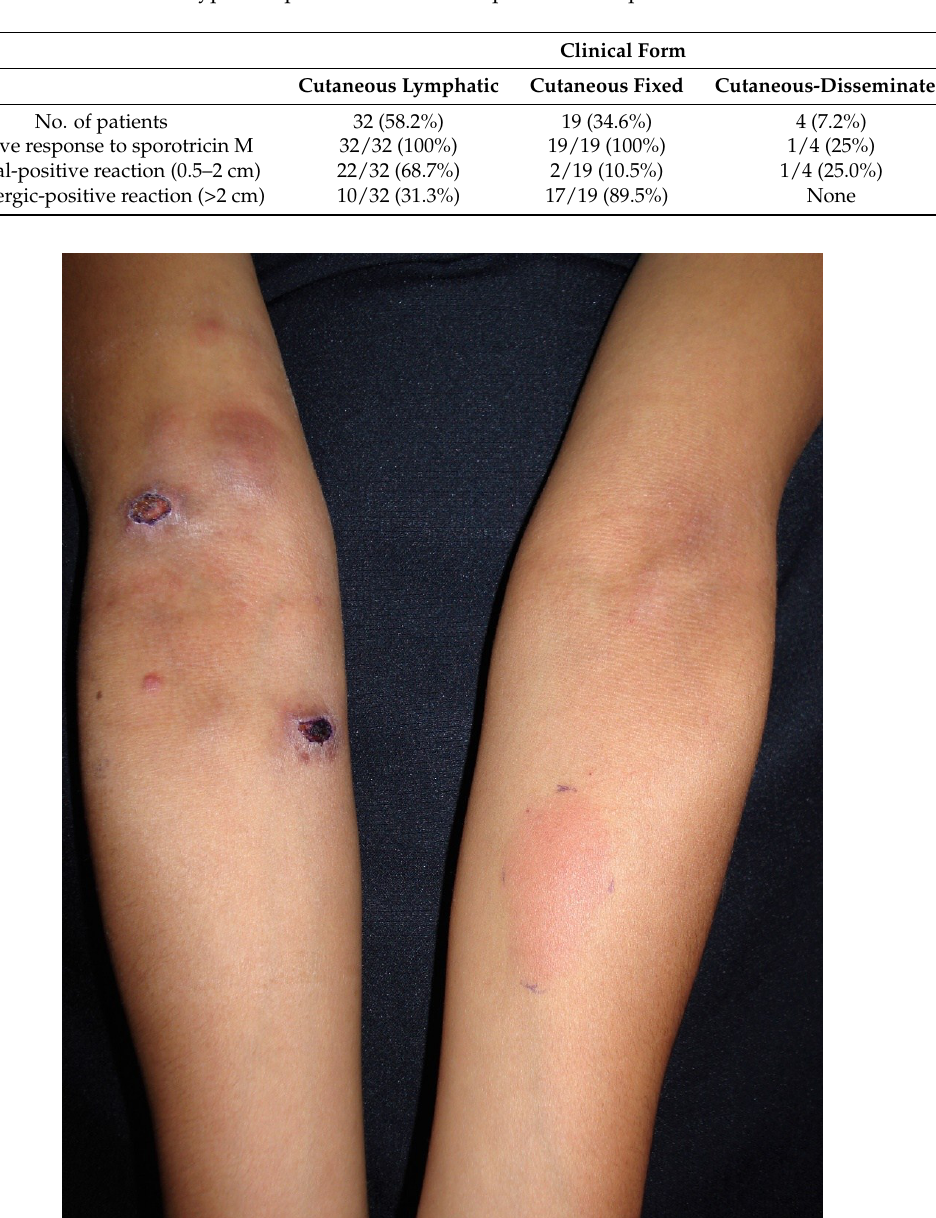
Figure 3. Cutaneous lymphangitic sporotrichosis and its hyperergic response (>2 cm induration and erythema) to sporotrichin M.